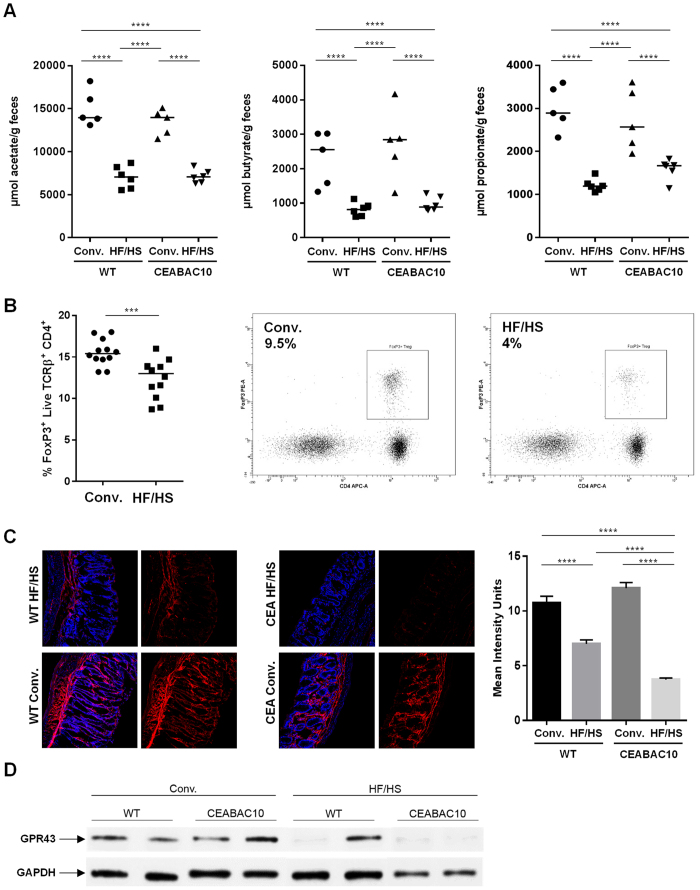
Western diet decreases the level of SCFA produced by intestinal microbiota modulating immune response.(A) Acetate, Butyrate and Propionate in fecal samples were measured by gas chromatography, (B) Treg population in MLN of mice was analyzed by flow cytometry and representative plots gated were obtained on live TCRβ+ MLN cells from conventional or HF/HS fed mice, (C) GPR43 receptor expression was visualized by confocal microscopy and (D) image intensity was quantified using the ImageJ software. *P < 0.05; **P < 0.01; ***P < 0.001, ****P < 0.0001.